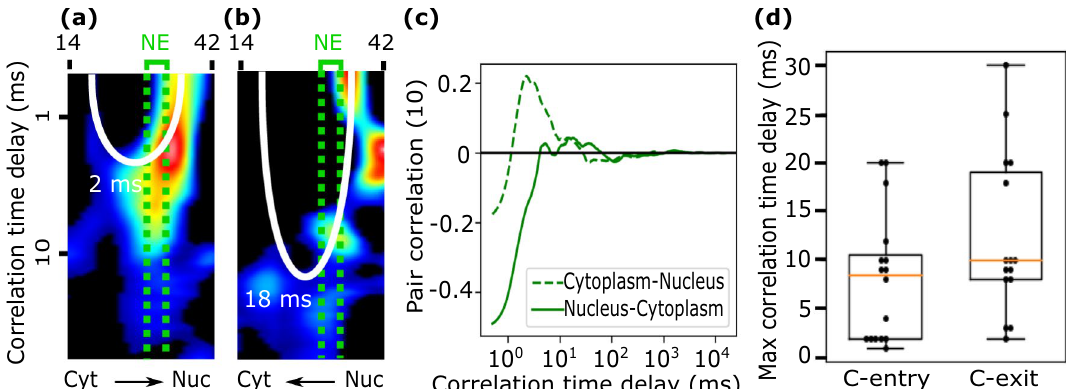
Figure 7. pCF analysis reveals C protein import and export. A pCF analysis of nucleocytoplasmic C-DENV transport shows the C-protein shuttles in both directions. From the complete intensity kymogram we select the region (pixels 14 to 42) in the cytoplasm (or nucleus) that at a distance of 10 pixels entirely correlates with the nucleus (or cytoplasm). ( A ) pCF kymograms analyzed in a direction from cytoplasm to nucleus (dashed green line in C ). ( B ) pCF kymograms analyzed in a direction from nucleus to cytoplasm (solid green line in C ). ( C ) Average pCF(10) of lines crossing NE calculated for the kymograms shown in ( A , B ). The transport of C-protein from cytoplasm-to-nucleus is favored compared with that of C-protein diffusing in the opposite direction as indicated by the amplitude of the pCF peaks. ( D ) Box plot for each direction, C-entry indicates cytoplasm to nucleus direction with an interquartile range of 2 to 11 ms. C-exit indicates nucleus to cytoplasm direction with an interquartile range of 8 to 19